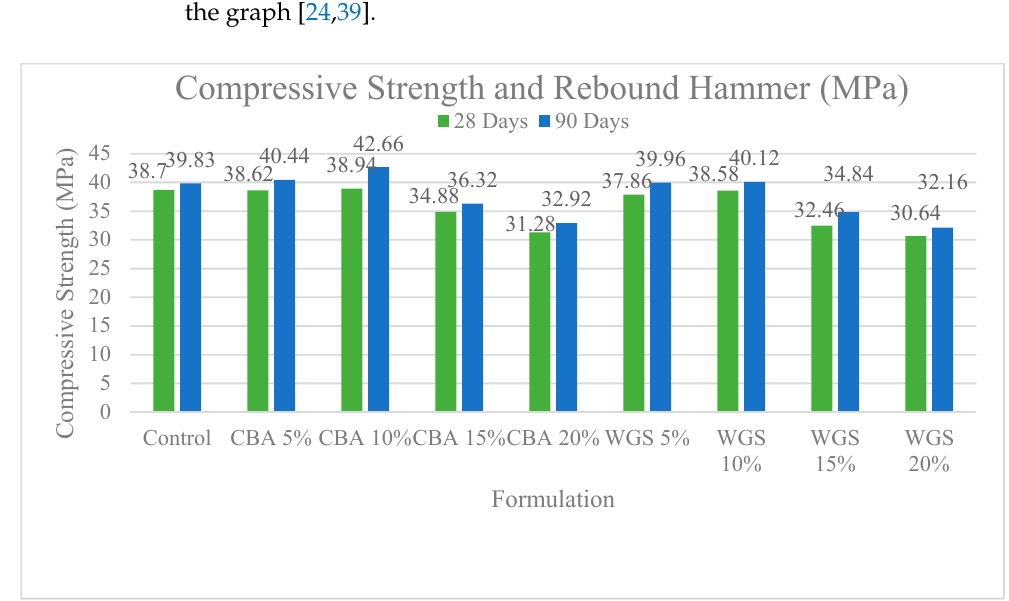
Figure 5. Comparison chart of rebound number of concrete at 28 and 90 days.